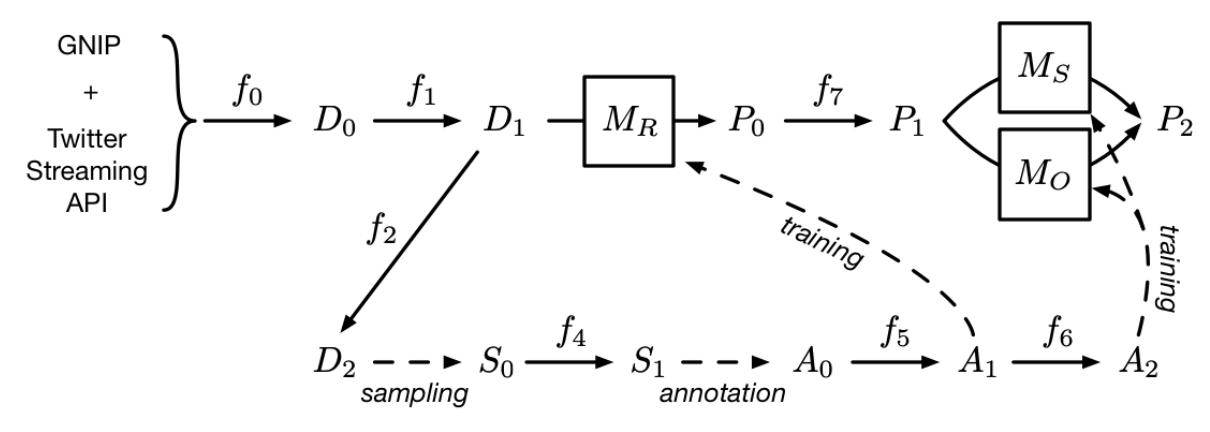
Figure 1. Overview of the data processing pipeline. Labels f 0-7 denote filtering steps, D 0-2 datasets, S 0-1 samples, A 0-2 annotation sets, and P 0-2 predictions. M R , M S , and M O represent machine learning models. API: application programming